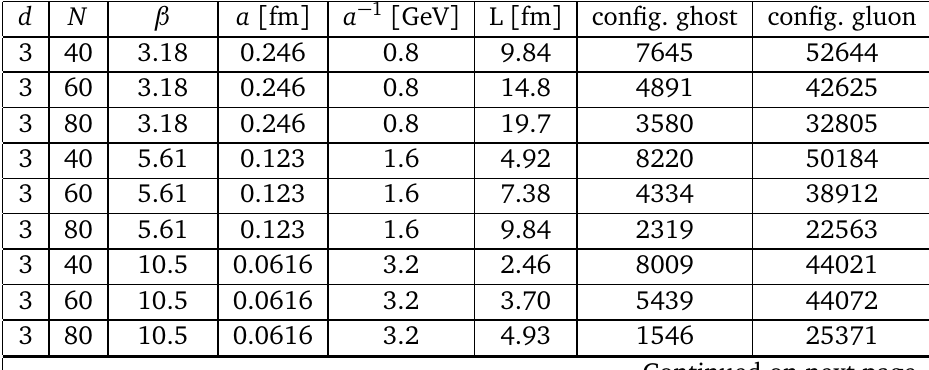
Table 1: Number and parameters of the configurations used, ordered by dimension, lattice spacing, and physical volume. In all cases 2 ( 10 N + 100 ( d − 1 )) thermalization sweeps and 2 ( N + 10 ( d − 1 )) decorrelation sweeps of mixed updates [ 40 ] have been performed, and auto-correlation times of local observables have been monitored to be at or below one sweep. See [ 41 ] on details of how the lattice spacing was